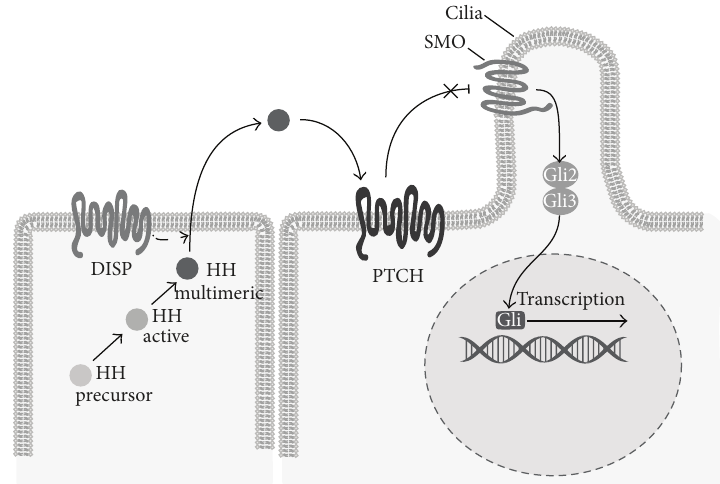
Figure 4: Schematic of Hedgehog signaling pathway. The initially insoluble Hedgehog (HH) ligand precursor undergoes a series of intracellular modifications before reaching an active, multimeric form. Following release from the membrane by Dispatched (DISP), the morphogen binds to Patched (PTCH), which releases Smoothened (SMO) from constitutive inhibition by PTCH. This activates the Gli2/3 complex, which goes on to promote gene expression of Gli1, while repressing the transcriptional repressor Gli3.